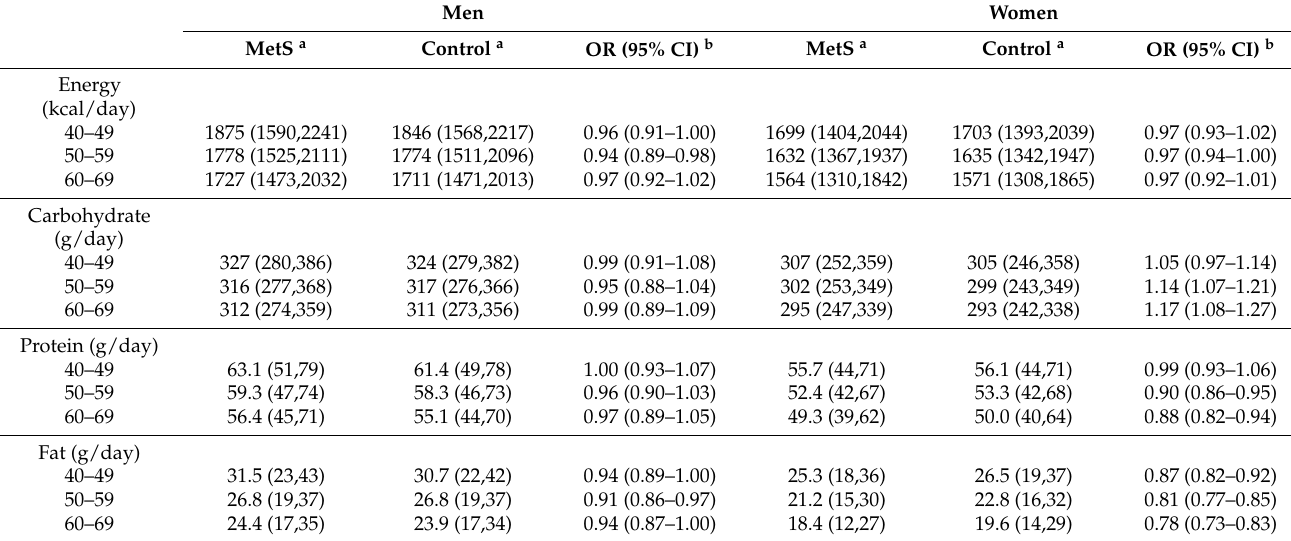
Table 3. Odds ratios (OR) and 95% confidence intervals (CI) of metabolic syndrome according to macronutrient intake by age group, the HEXA-G study, 2004–2013. Men